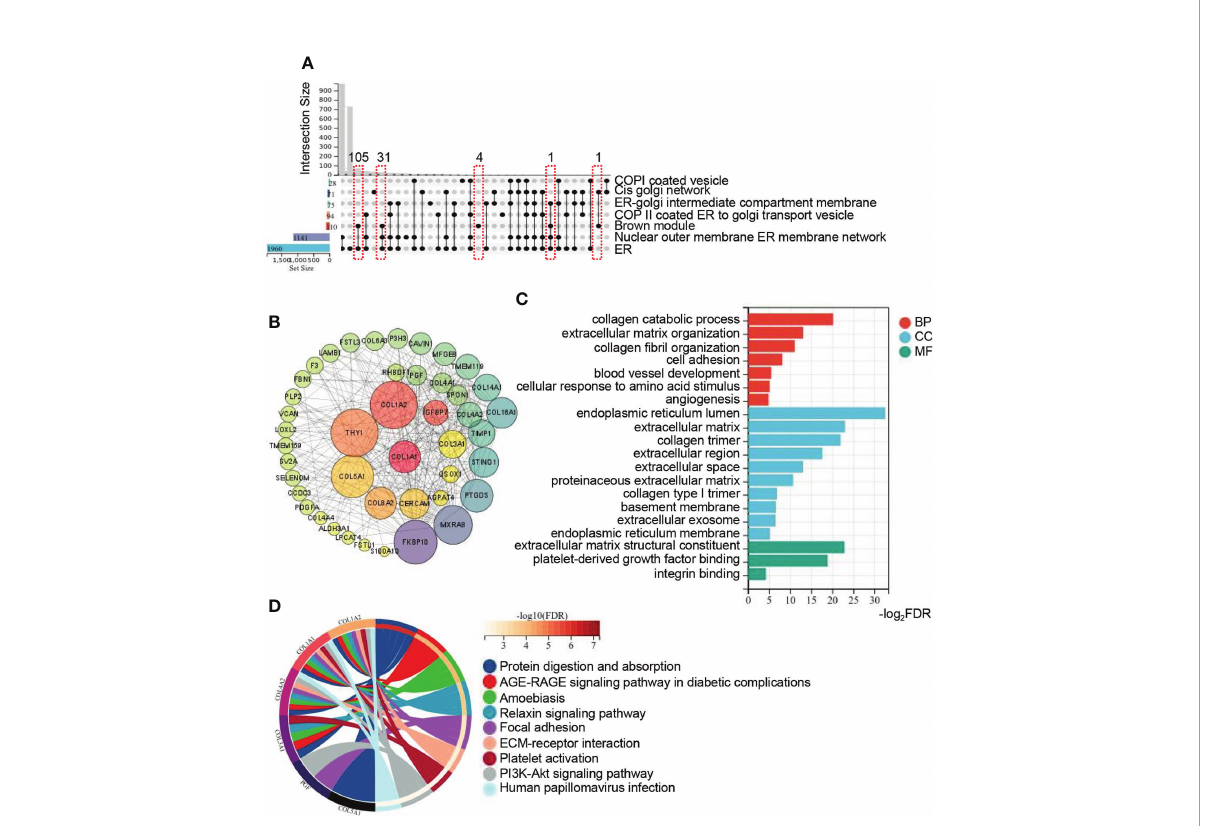
FIGURE 3 Identi fi cation of hub genes in brown module and function annotation. (A) Upset plot summarizes the intersection among ER related gene sets from GO_CC and genes from brown module. The bar plot in the left represents the gene number of each set. The lines in red frames represent the number of intersection genes of the brown module and other gene sets. (B) Network of genes with the weight (TOM) more than 1.0 in the brown module. Genes in the central highlighted red to green are the top 20 hub genes calculated by MCC. Both the color and size of the circle are proportional to the intramodular connectivity. (C, D) GO and KEGG pathway enrichment analysis of the top 20 hub genes from brown module. Circos plot is to indicate the relationship between genes and KEGG terms. ER, endoplasmic reticulum; GO, gene ontology; BP, biological process; CC, cellular component; MF, molecular function; KEGG, kyoto encyclopedia of genes and